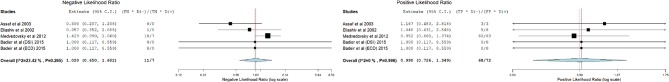
Forest plot showing negative and positive likelihood ratios of the IC-MSI studies (individual studies: size of the squares are proportional to weights used in meta-analysis; the summary measure: center line of the diamond; associated 95% confidence intervals: lateral tips of the squares and the diamond).